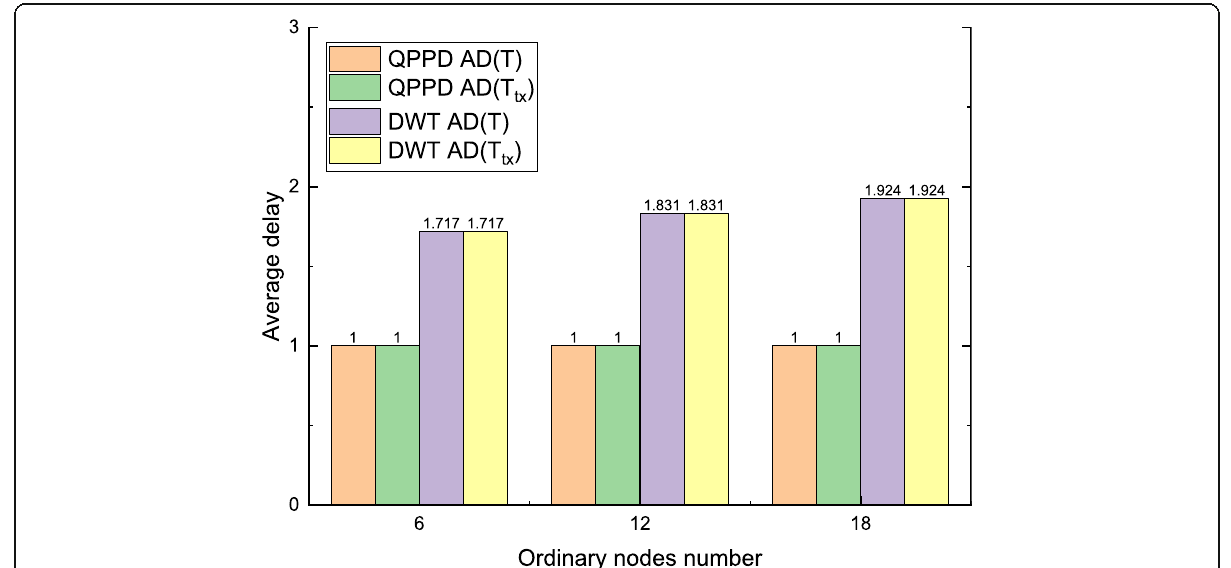
Fig. 26 The total volume of data is equal to 3 in each cycle; the average delay of high priority